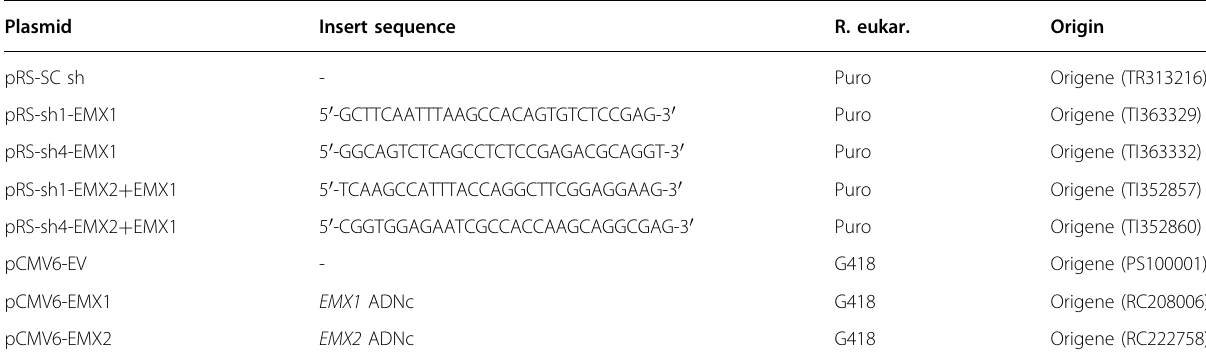
Table 1 Plasmids used in this work. Plasmid Insert sequence